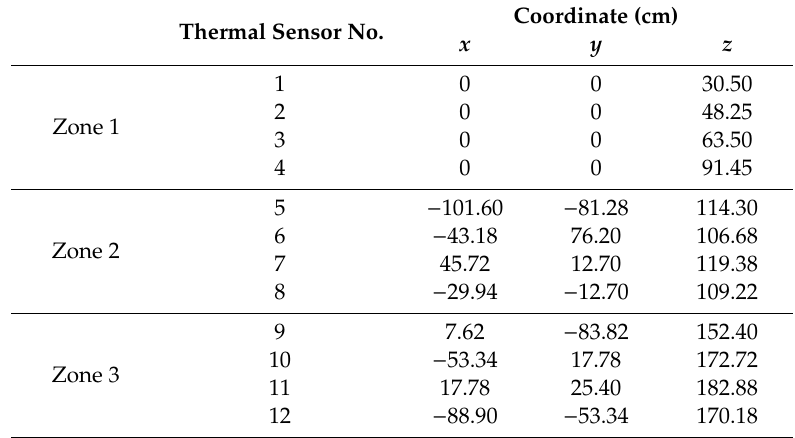
Table 1. Thermal sensor coordinates (The center of the tree trunk is considered as the origin of the coordinates, as shown in Figure